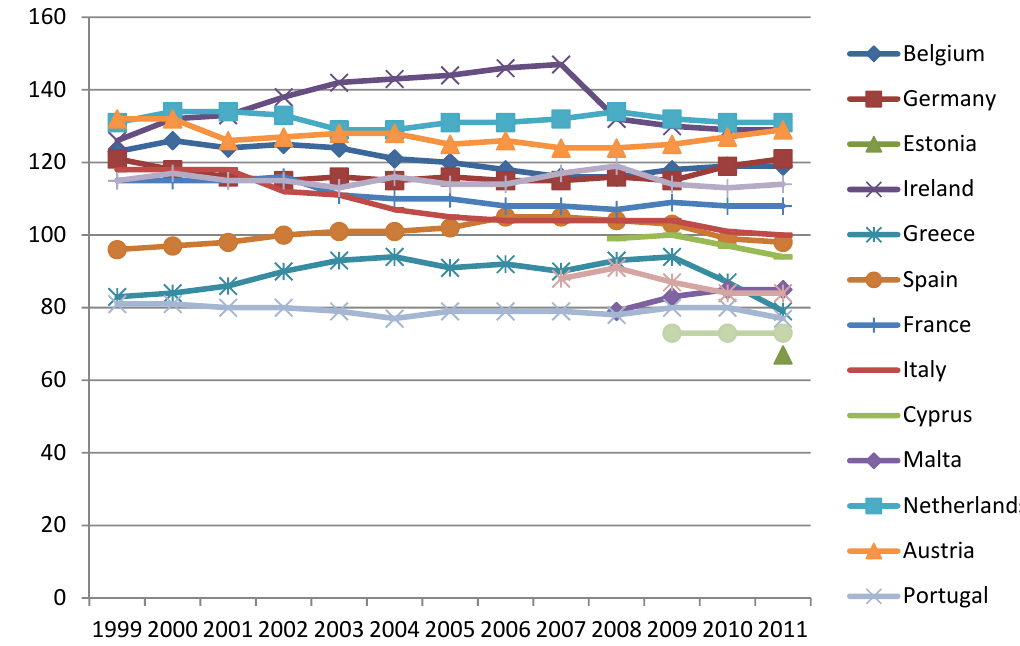
* Only for years of Eurozone membership. Own edition based on